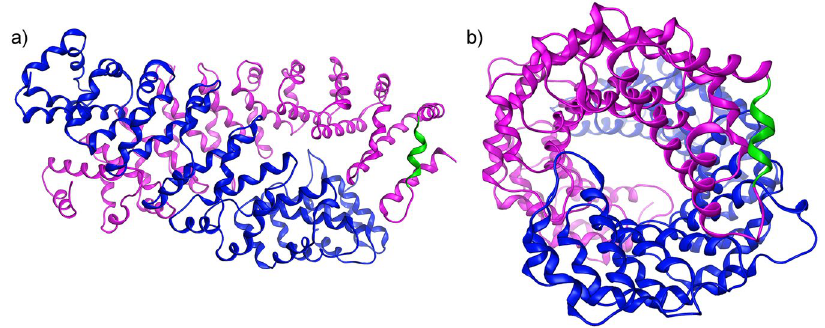
Figure 4. The 3D homology model of the dimeric LRRK2 ARM domain. ( a ) The armadillo repeats of the two LRRK2 molecules establish a concave inner conformation to each monomer. In this model of the isolated ARM repeat domain, the sites capable of dimerization are lined with residues that establish a hydrophobic core. Shown are each of the modeled LRRK2 monomers (presented in blue and magenta ribbon) of the LRRK2 ARM region. Each structure bears a specific α -helical motif that is exposed on the molecule located near the C-terminus of the ARM repeat region. One such motif is highlighted in green. ( b ) When viewed from the side, the two monomers display a supercoiled dimeric-like formation that is typical of armadillo repeat containing